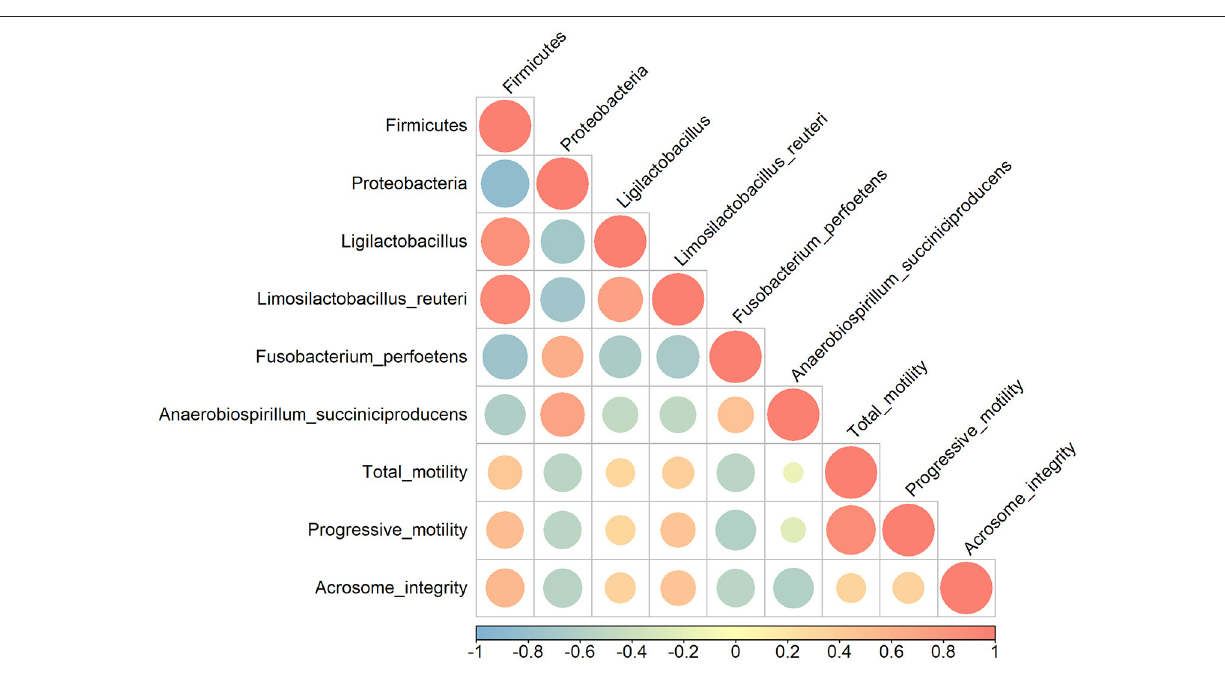
Frontiers in Veterinary Science |